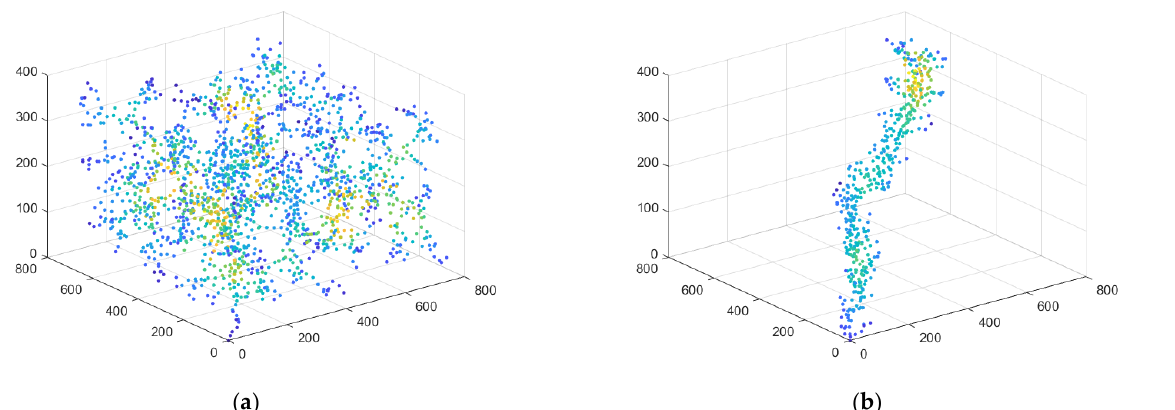
Table 2. Number of nodes, path length, and time cost of the conventional RRT